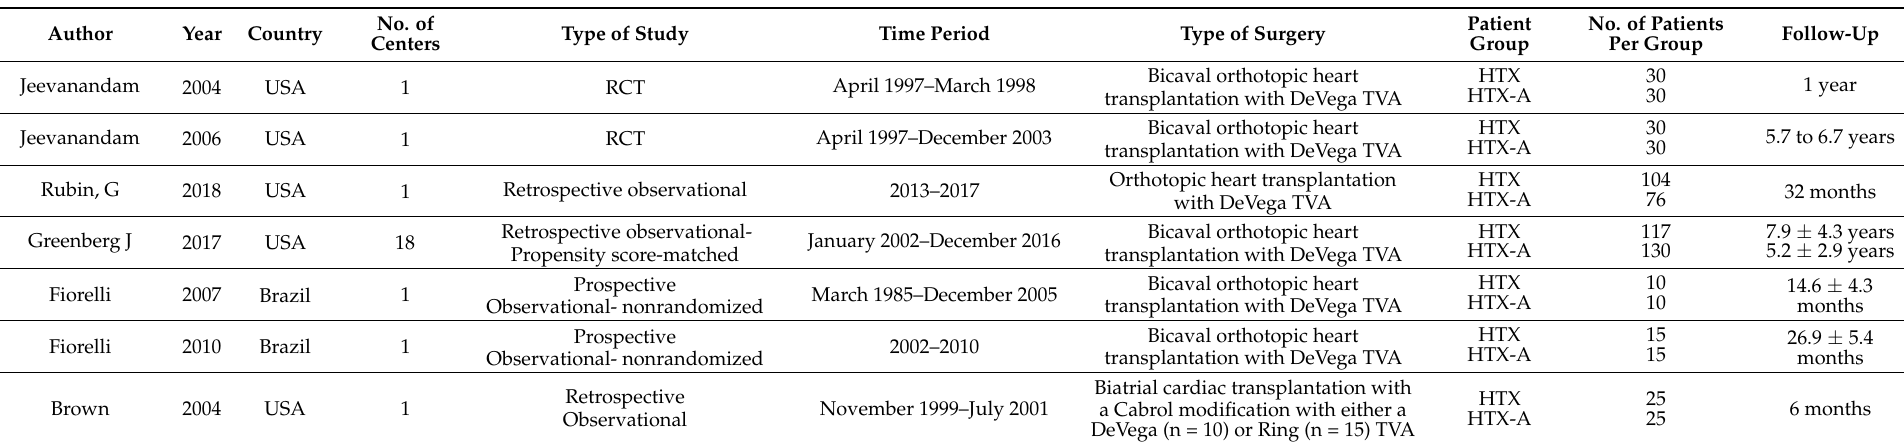
Table 1. Summary of included studies.